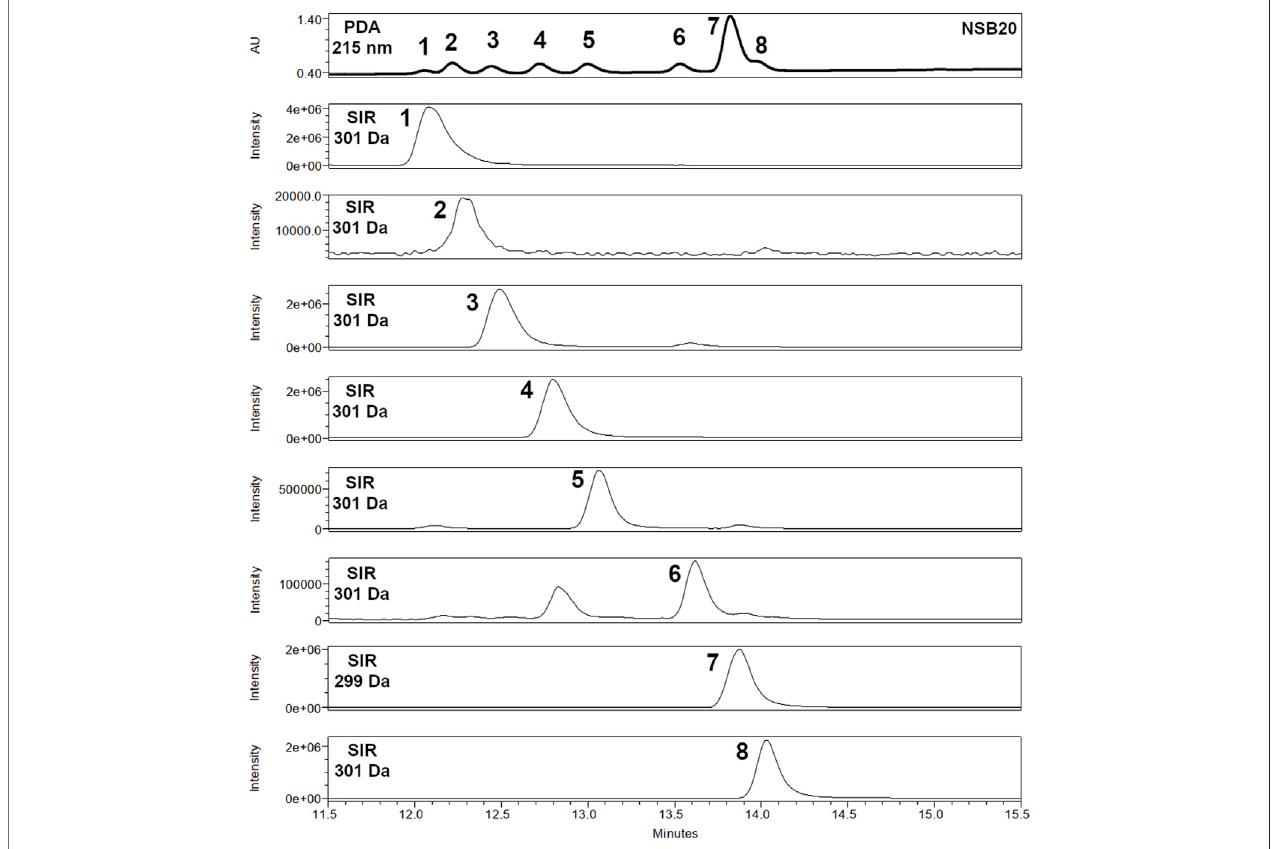
FIGURE 2 | Detailed section (RT 11.5 – 15.5 min) of the PDA chromatogram of spruce balm sample NSB20 (at 215 nm) and UHPSFC-ESI-MS Extracted Ion Chromatograms (negative mode, 299 and 301 Da) of diterpene resin acids 1 – 8 with optimized parameters on a 2-PIC column (3.0 mm × 100.0 mm, 1.7 µm).